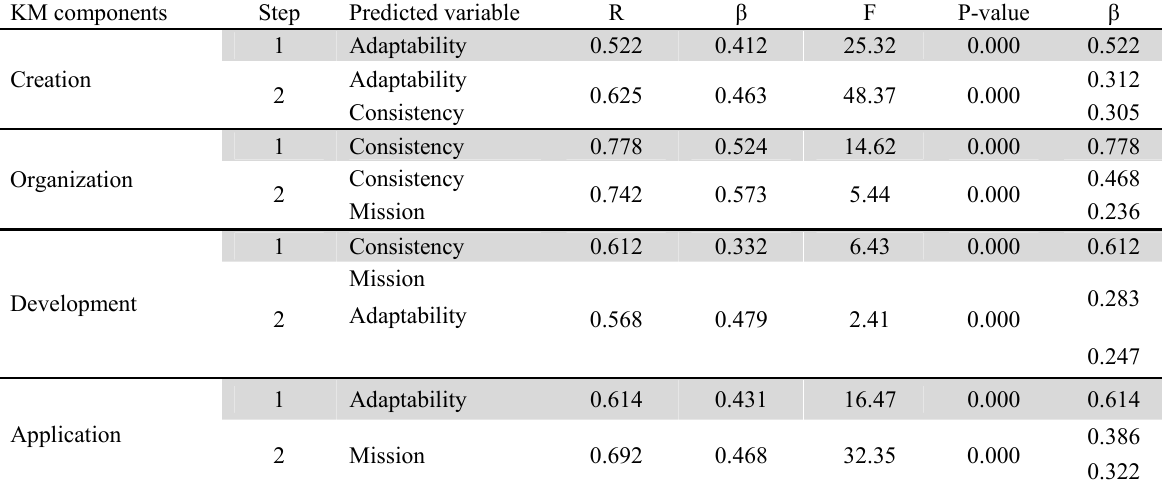
The summary of stepwise regression